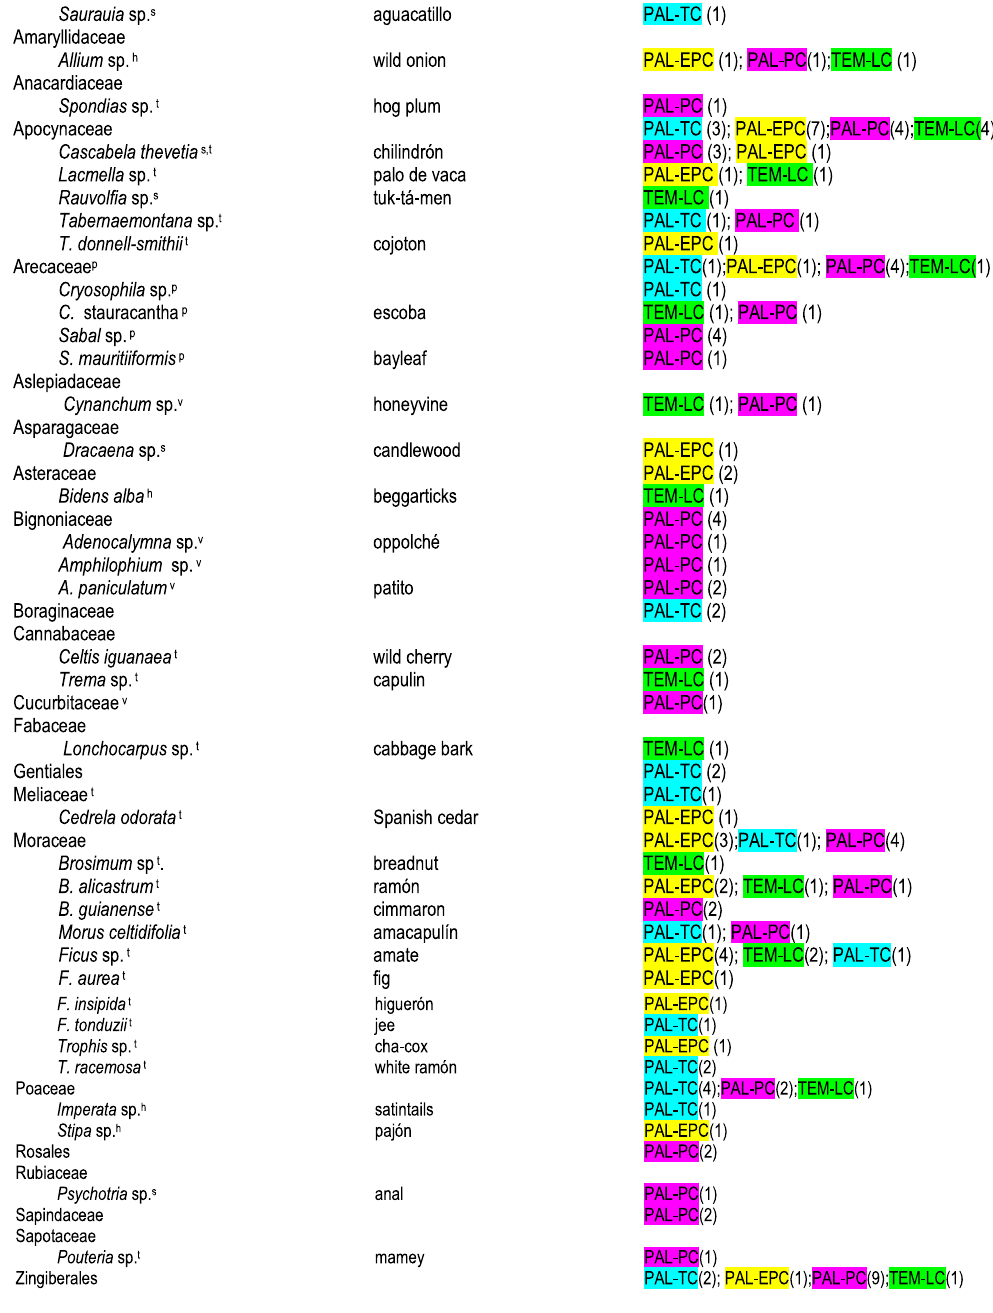
Table 1. Environmental DNA results from Temple and Palace reservoirs at Tikal. Palace, Early Preclassic period = PAL-EPC (WA07); Temple, Late Classic period = TEM-LC (WA09); Palace, Terminal Classic period = PAL-TC (WA01); Palace, Postclassic period = PAL-PC (WA08). Growth habit: t tree, s shrub, h herb, v vine, p